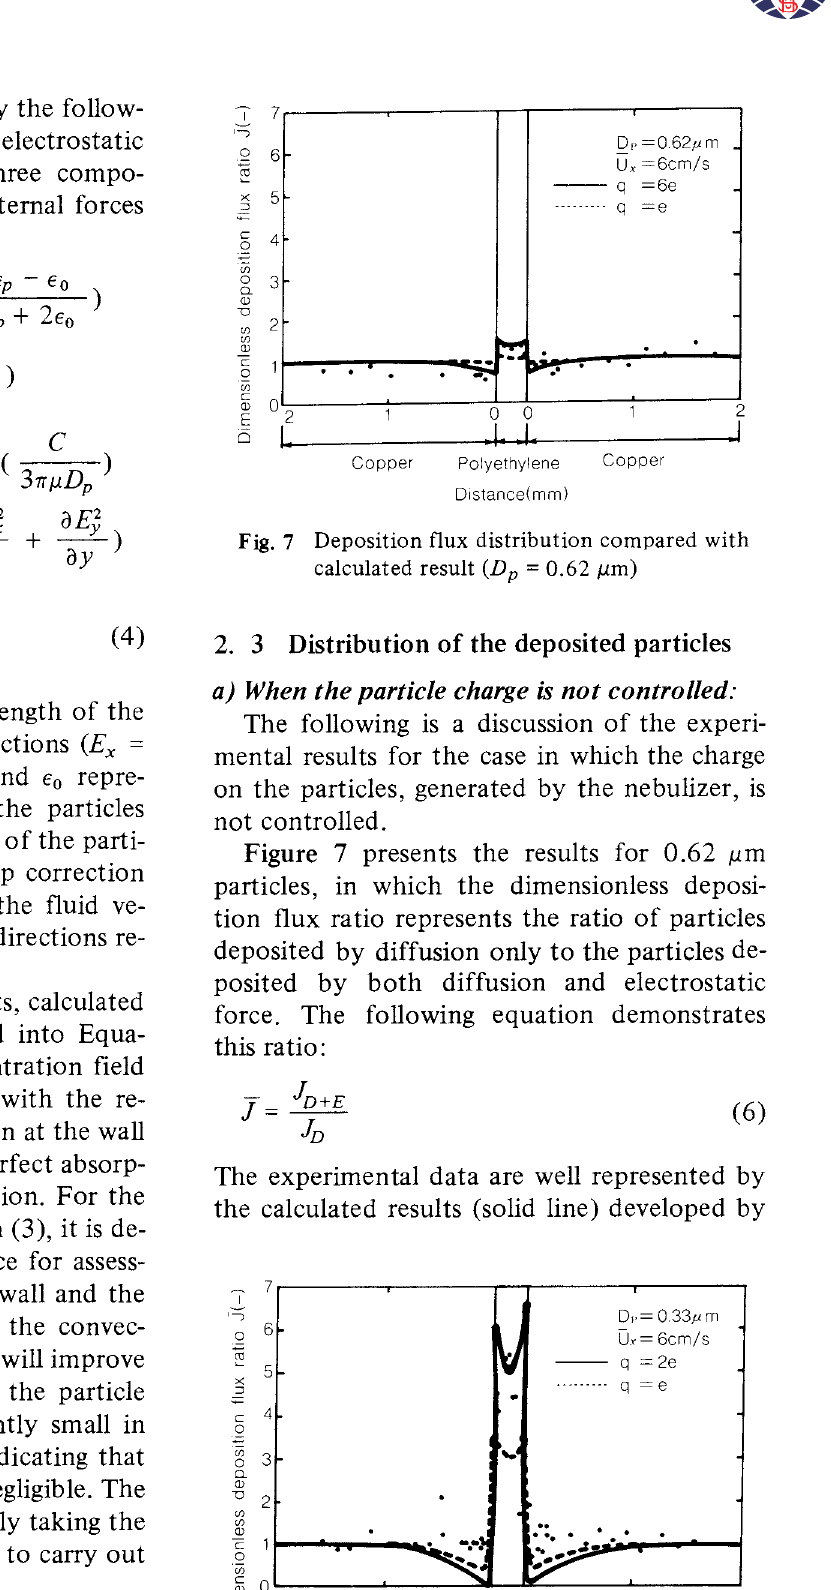
Fig. 8 Deposition flux distribution compared with calculated result (Dp = 0.33